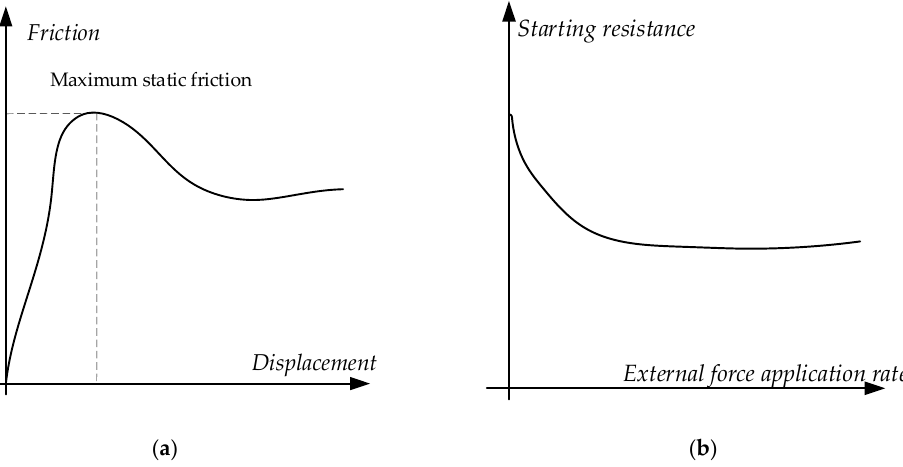
Figure 5. Friction properties: ( a ) Maximum static friction force; ( b ) Variable static friction.